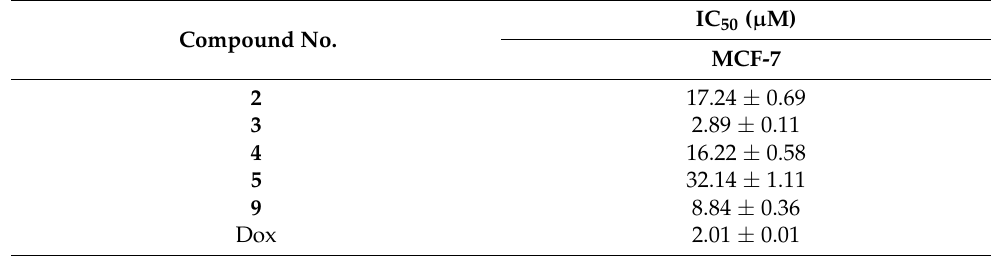
Table 1. In vitro cytotoxic activity of benzo[ g ]quinoxaline derivatives 2–5b and 9 on the MCF-7 breast cancer cell line. Data are expressed as the mean ± SD with n = 3 experiments. Compound No.